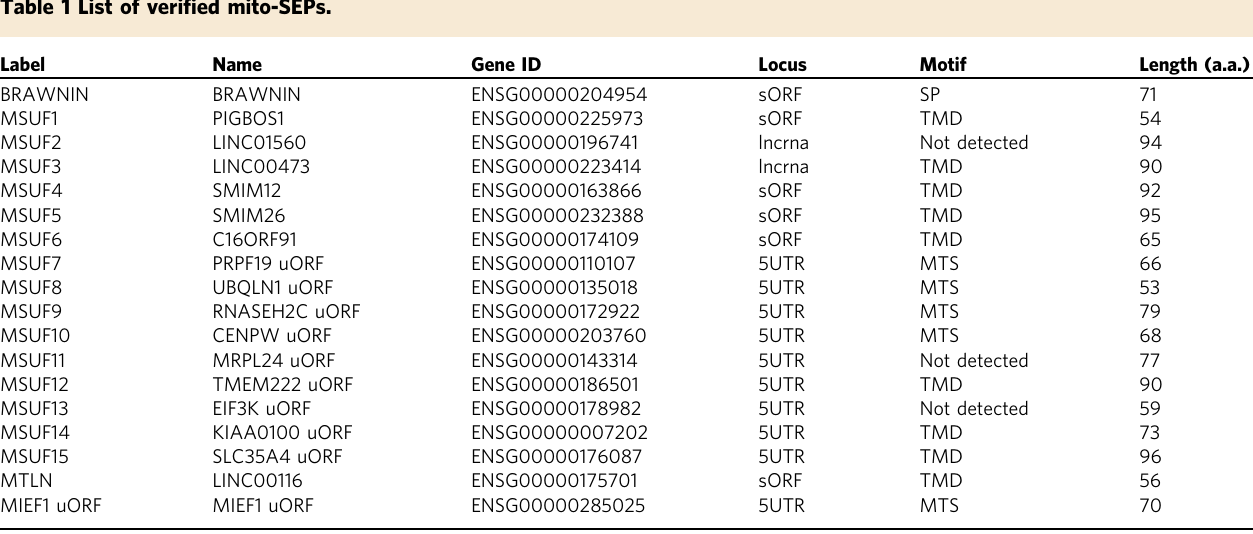
Table 1 List of veri fi ed